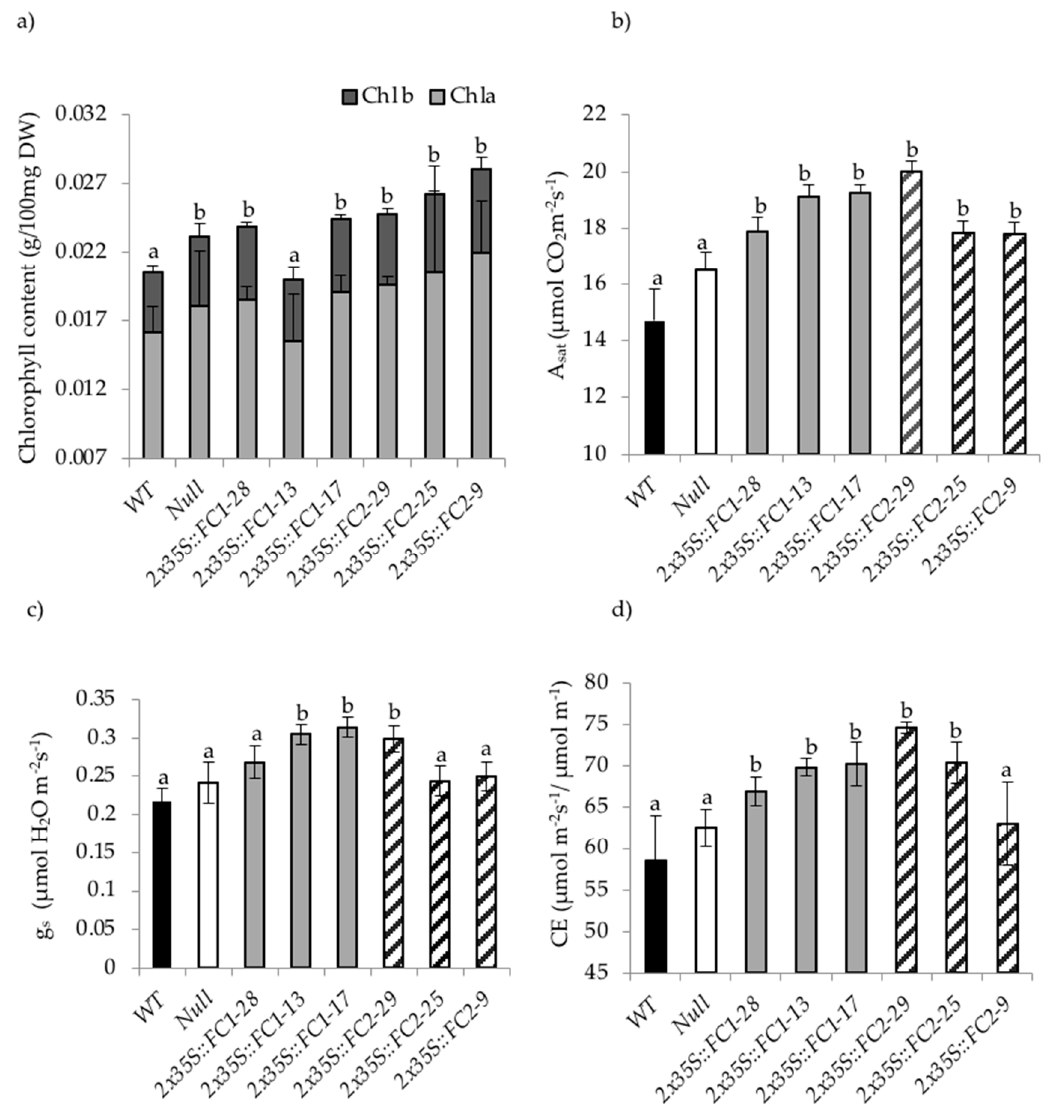
Figure 6. Photosynthetic performance of HvFC overexpressing transgenics relative to controls. ( a ) Chlorophyll a and b content, ( b ) photosynthesis rate under saturated light ( A sat ), ( c ) stomatal conductance ( g s ), and ( d ) carboxylation efficiency (CE) of three independent transformation events overexpressing either HvFCI or HvFC2 relative to WT and null controls. Data are shown as mean values ± standard error from 4 to 5 different plants. Means with the same letter are not significantly different at p < 0.05, one-way ANOVA.